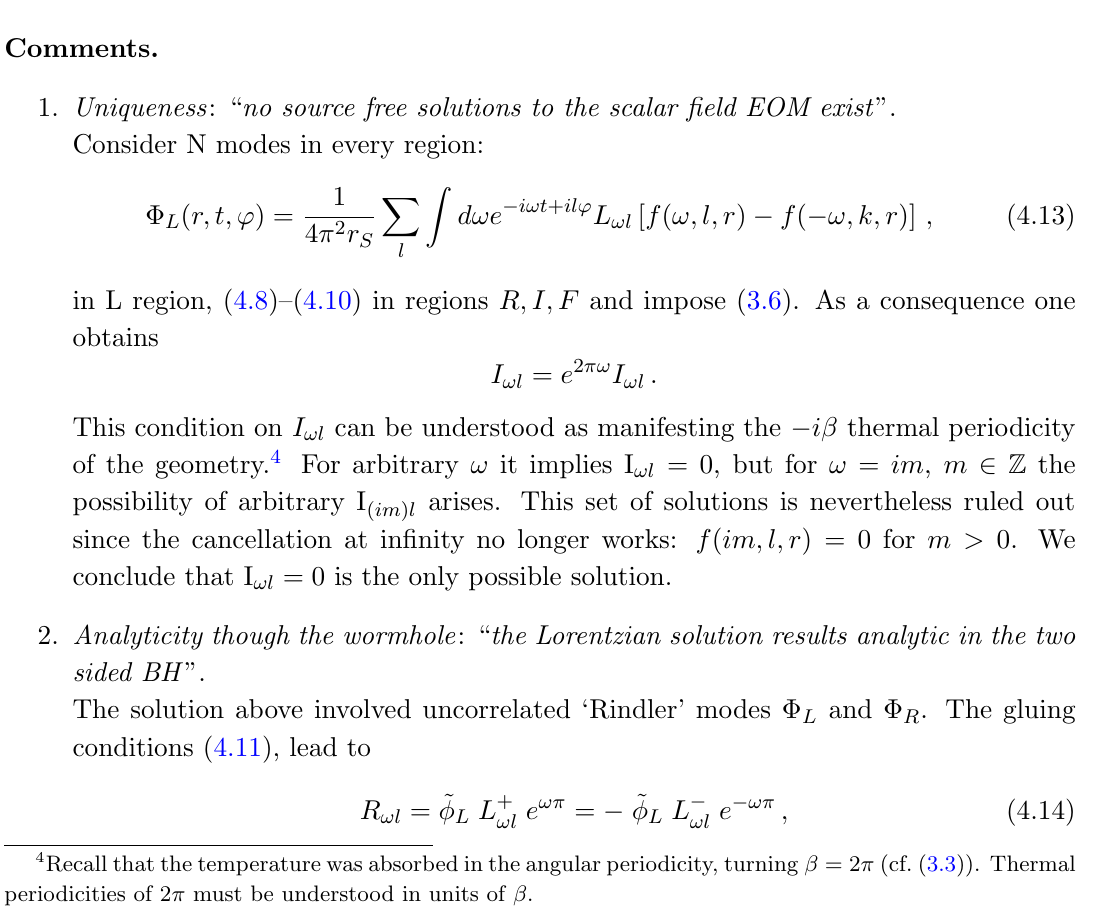
Figure 5 . (a) The blue line denotes the ! -integration contour in the Lorentzian solution (4.6). Crosses show the location of the poles of f ( !; l; r ) while circles those of f ( (cid:0) !; l; r ). (b) The Feynman-like blue line represents the integration path in (4.17). The red crosses and circles repre- sent the poles of s ( !; l; r ), which lie on the real